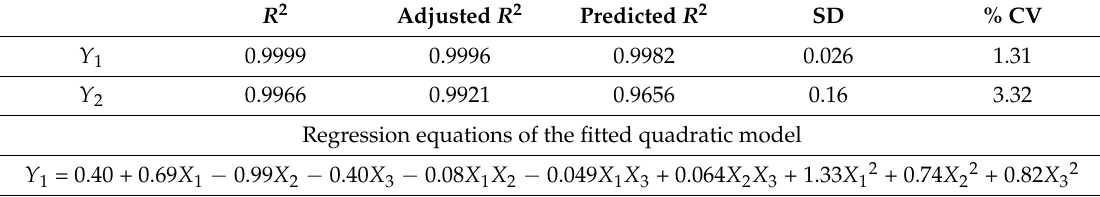
Table 2. Regression analysis for responses for fitting to quadratic